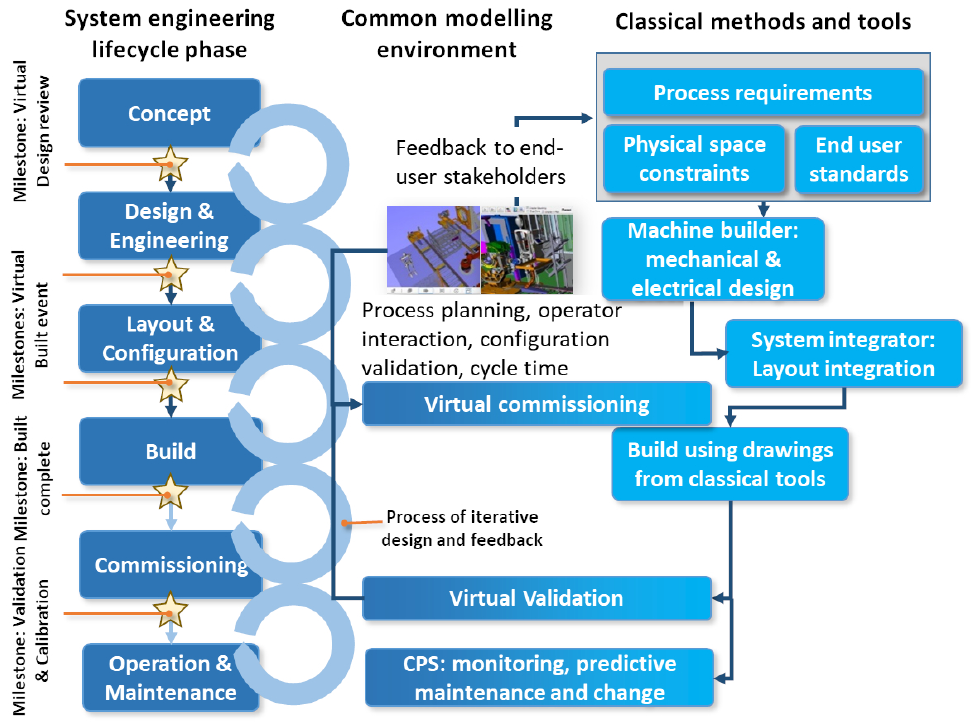
Figure 3. Engineering workflow (updated figure of